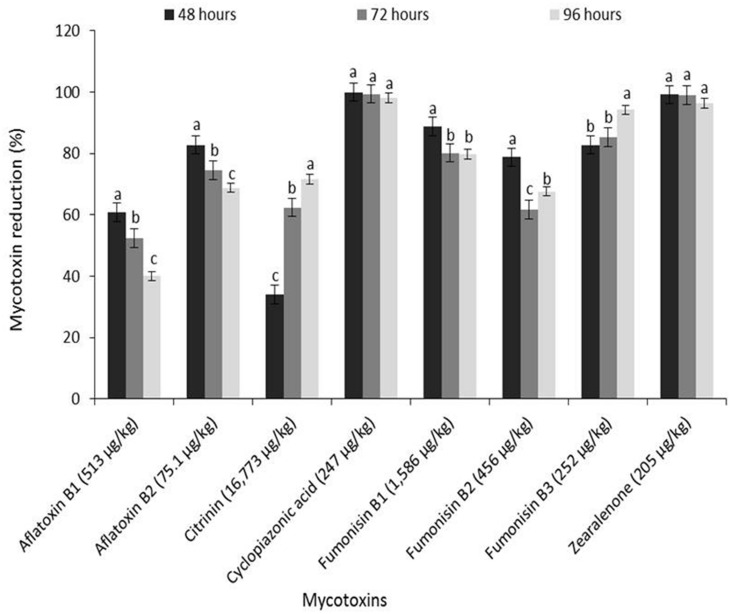
Reduction (%) of mycotoxins in freshly fermented ogi due to fermentation during steeping of yellow maize grains. Concentrations given on x-axis indicate mycotoxin levels in raw maize grains before steeping. Aflatoxin M1 (22.7 μg/kg) was reduced by 100% at all time intervals. Vertical lines on bars indicate the standard error of mean (α = 0.05). Bars with different alphabets are significantly different by DMRT at α = 0.05.